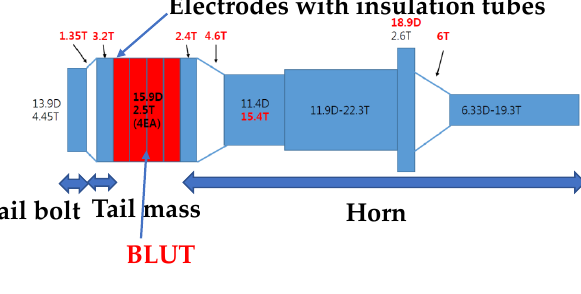
Electrodes with insulation